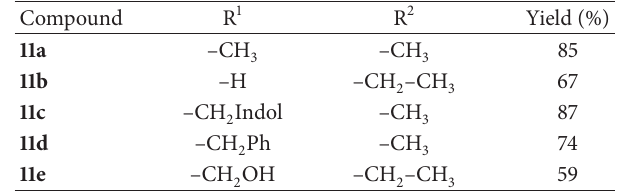
Table 1: 𝛼 -Halomethyl ketones synthesized from 𝛼 -amino acids. Table 2: Dialkynes synthesized from 𝛼 -amino